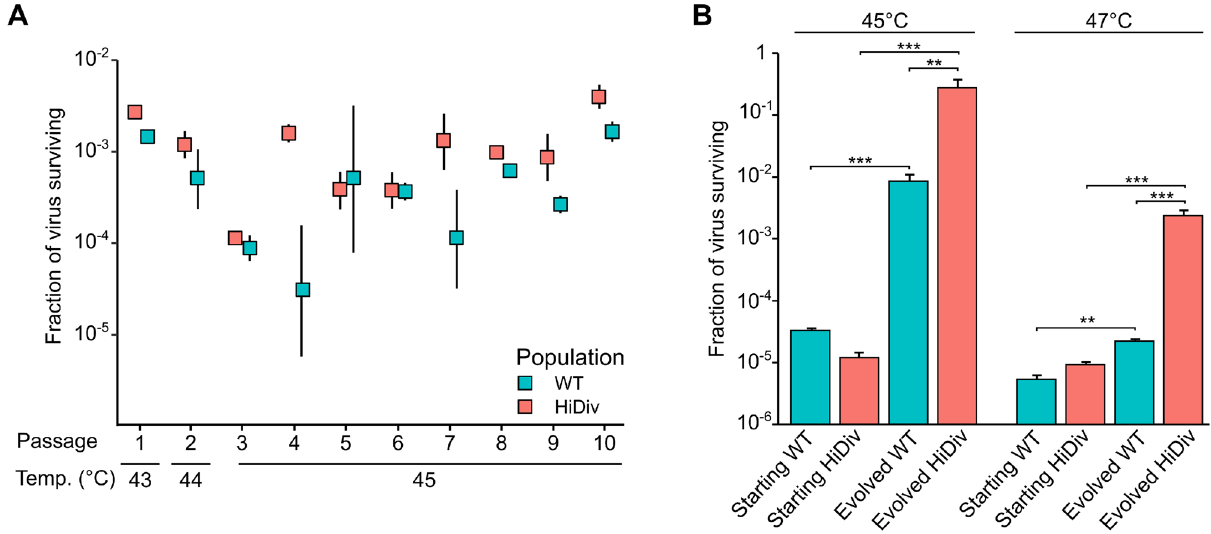
Figure 2. Experimental evolution regime for selection of resistance to thermal inactivation. ( A ) Experimental evolution of HiDiv and WT populations under conditions of thermal inactivation. HiDiv or WT populations were subjected to heat treatment at the indicated temperature for 30 min. The surviving fraction was then amplified and used for the subsequent passage. This process, representing a single passage, was repeated a total of ten times at the indicated temperature. The mean fraction of virus surviving and standard deviation for the three replicates are plotted. ( B ) HiDiv populations show improved resistance to thermal inactivation compared to WT populations. The starting (passage 0) and the evolved (passage 10) HiDiv and WT populations were tested for their ability to resist thermal inactivation following incubation at 45 °C or 47 °C for 30 min. Each population was tested in triplicate and the average and standard deviation of the fraction of surviving viruses is indicated. *p < 0.05, **p < 0.01 ***p < 0.001 by two-tailed t-test on log-transformed values.